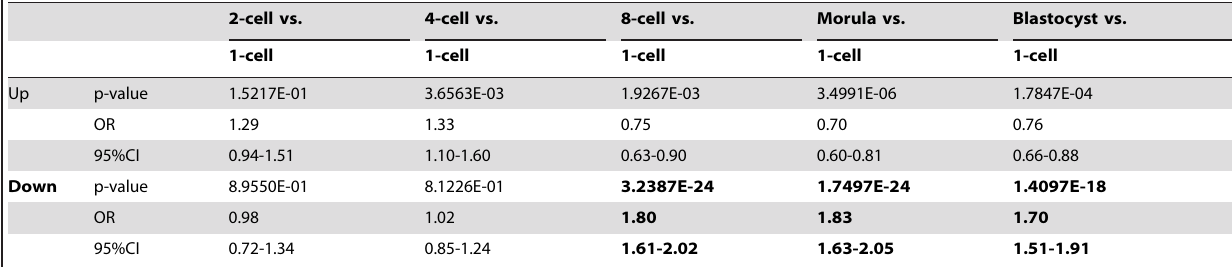
Chi-square test of association between human intragenic L1s and differential embryo gene expression stage (between cell division